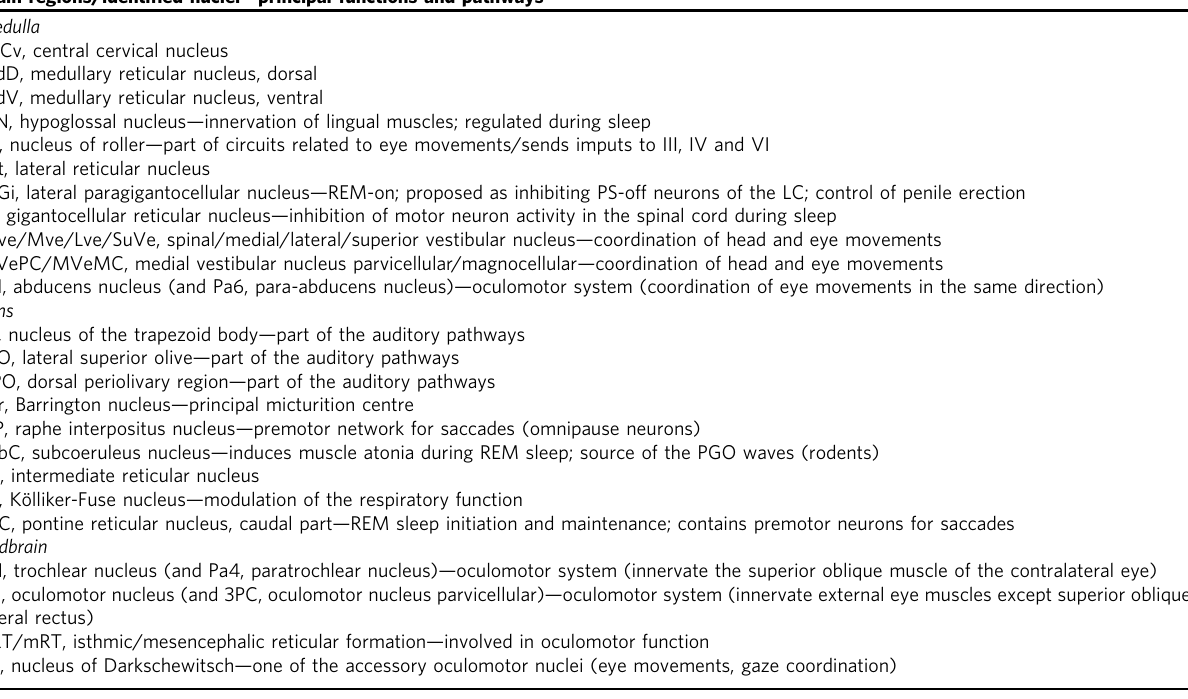
Brain regions/identi fi ed nuclei — principal functions and pathways